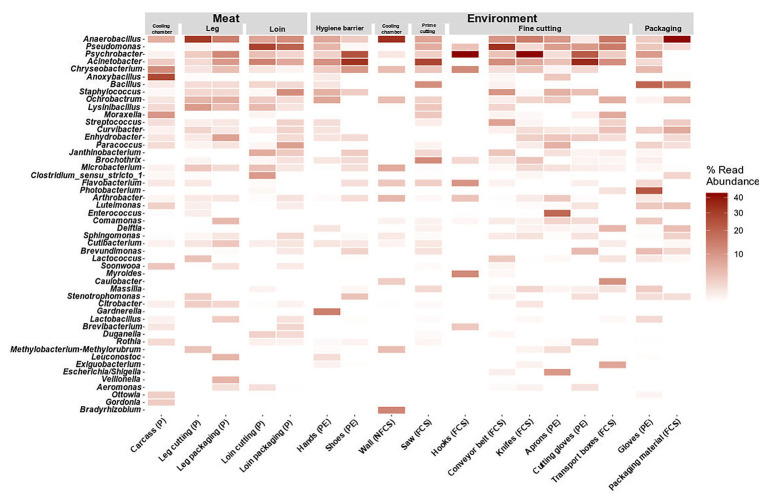
Heatmap of the top 50 most abundant genera grouped by position and split by type. Data represent average of ASV counts from replicate 16S rRNA gene libraries for each category. Sample categories are abbreviated: “product” (P), “food contact surface” (FCS), “non-FCS” (NFCS), and “personnel” (PE).